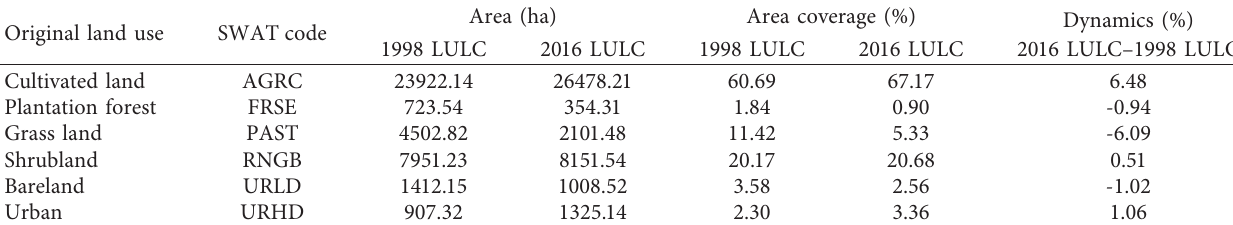
Table 6: Summary of spatial analysis result for land use